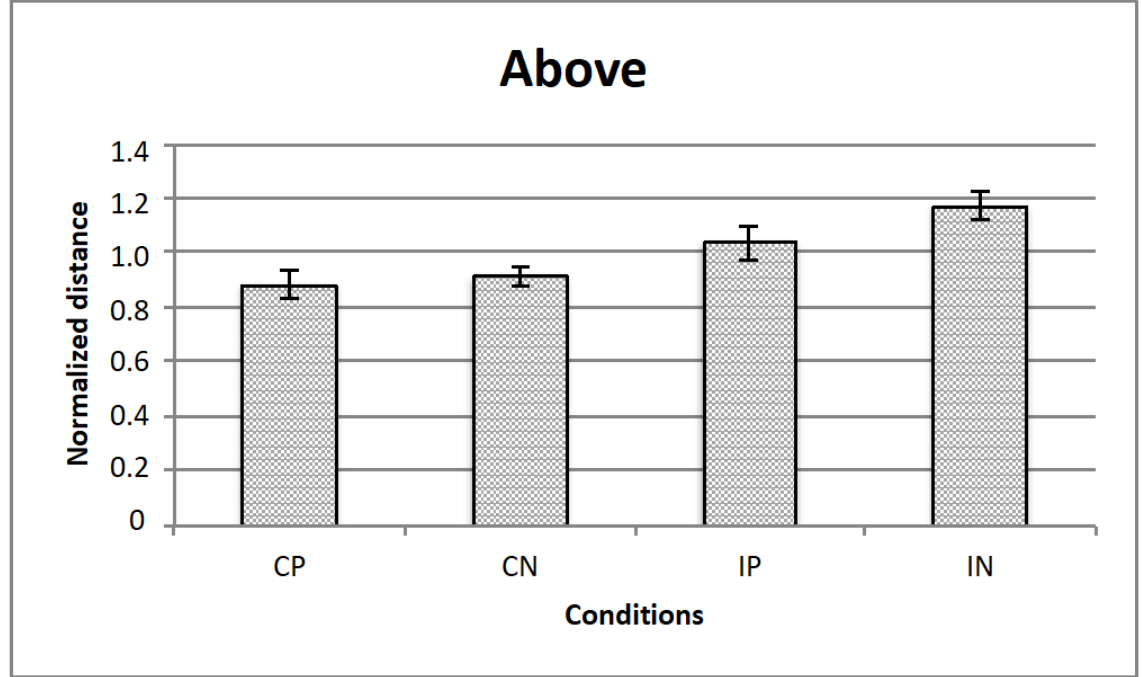
Figure 6. The figure represents the data for the illumination from above: The horizontal axis represents the experimental conditions (i.e., CP, CN, IP, IN), while the vertical axis is for the normalized critical distance (i.e., averaged across observers). Standard errors are